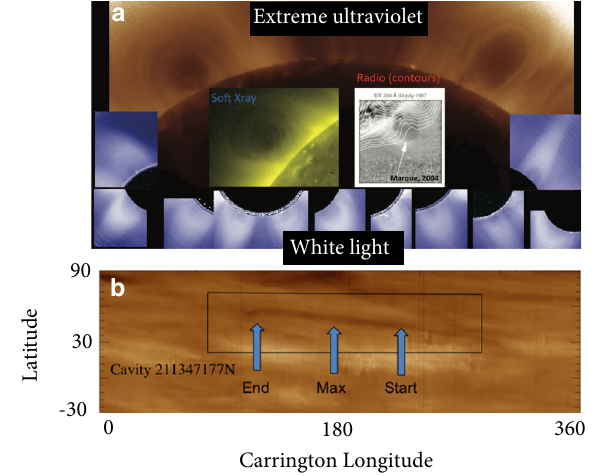
Fig. 12 Cavities are ubiquitous and three-dimensional. a Collage of cavities observed over a broad range of wavelengths. Extreme ultraviolet (EUV) observations from Solar Dynamics Observatory/Atmospheric ImagingAssembly(SDO/AIA);SXRfromHinodeX-rayTelescope(XRT);whitelightimagesfromMauna Loa Solar Observatory Mk4 K-coronameter (MLSO/Mk4); Radio contours (Nancay) overlaid on Solar and Heliospheric Observatory EUV Imaging Telescope (SOHO/EIT) observations (Marqué 2004). Image reproduced with permission from Gibson (2014), copyright by IAU. b Carrington latitude versus longitude plot constructed from AIA coronal limb observations (cropped to emphasize northern latitudes), showing the presence of an tunnel-like cavity extended in longitude. Image reproduced with permission from Karna et al. (2015b), copyright by